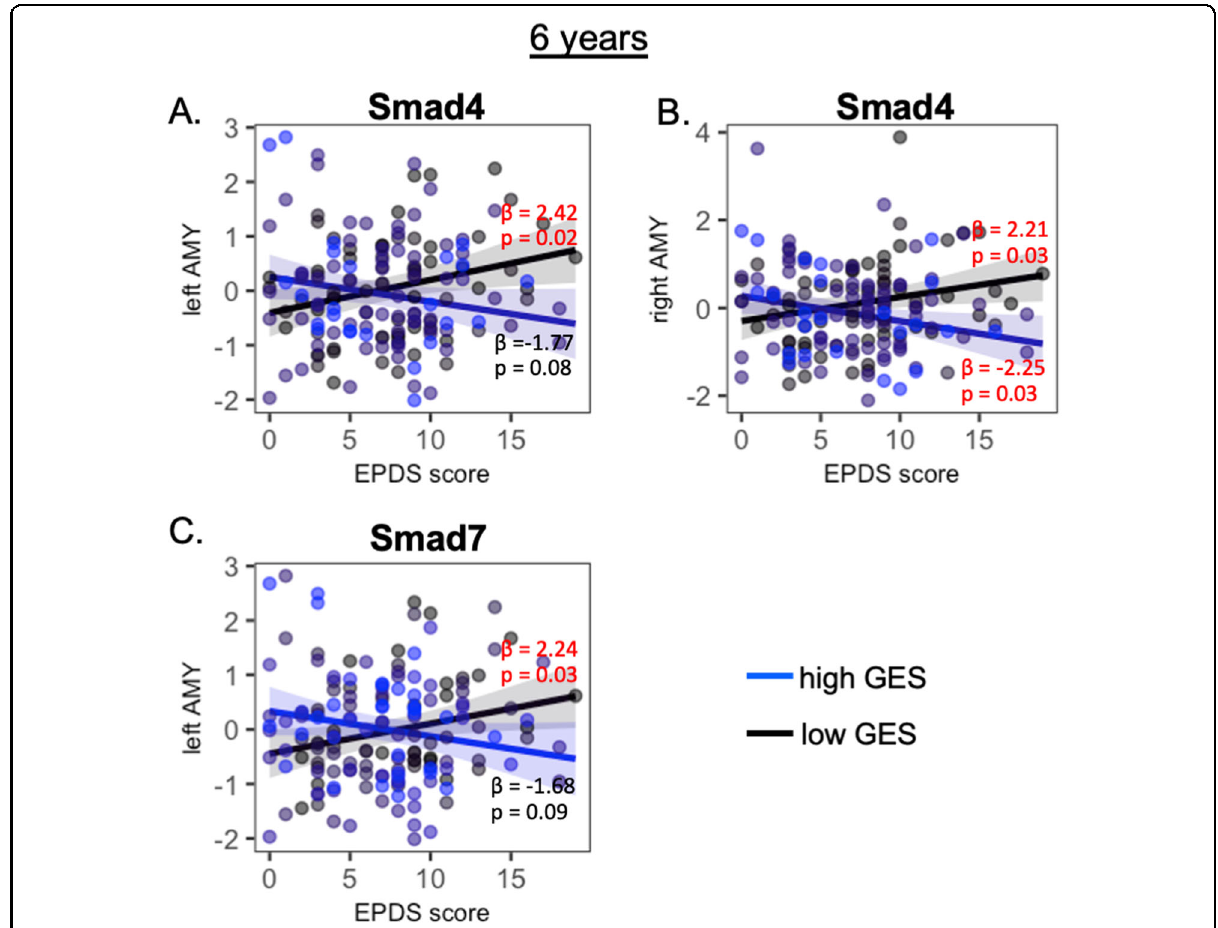
Fig. 4 Interaction between prenatal maternal depression and Smad on maygdala volumes. Post hoc analysis of the interaction between prenatal maternal depression and the genetic variants of Smad4 ( A , B ) and Smad7 ( C ) on the amygdala volume at the age of 6 years. The black and blue lines/dots represent the groups with low and high genetic expression scores (GES), respectively. β and p values in red indicate statistical signi fi